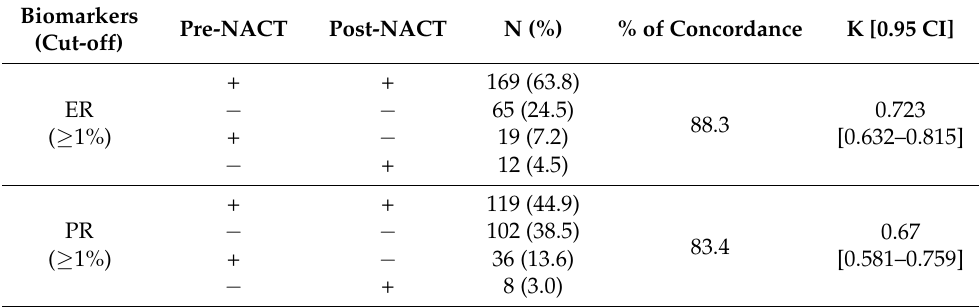
Table 2. Changes in the status of biomarkers between pre-NACT biopsy and post-NACT resection.